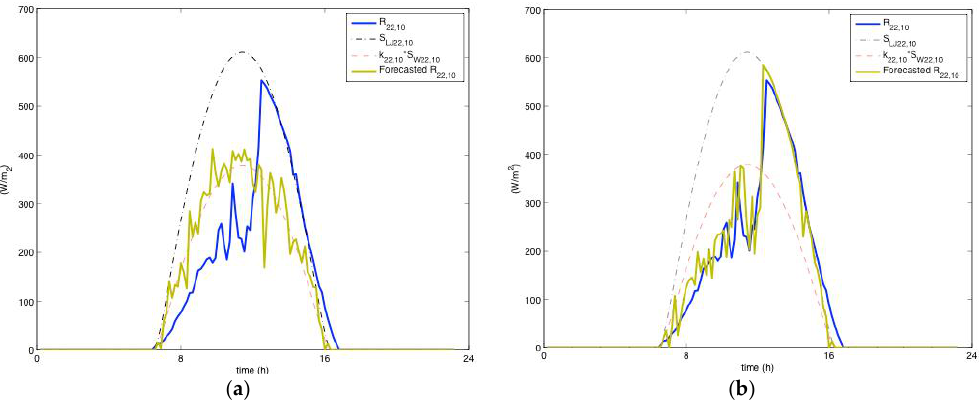
Figure 8. 22nd October: Measured solar irradiance, R 22,10 , forecasted solar irradiance, 𝑅̂ 22,10 , clear sky theoretical solar irradiance, S LJ22,10 , and product of the factor , k 22,10 by S W22,10 versus the time: ( a ) pure statistical forecasting; and ( b ) forecasting accounting for weather predictions.